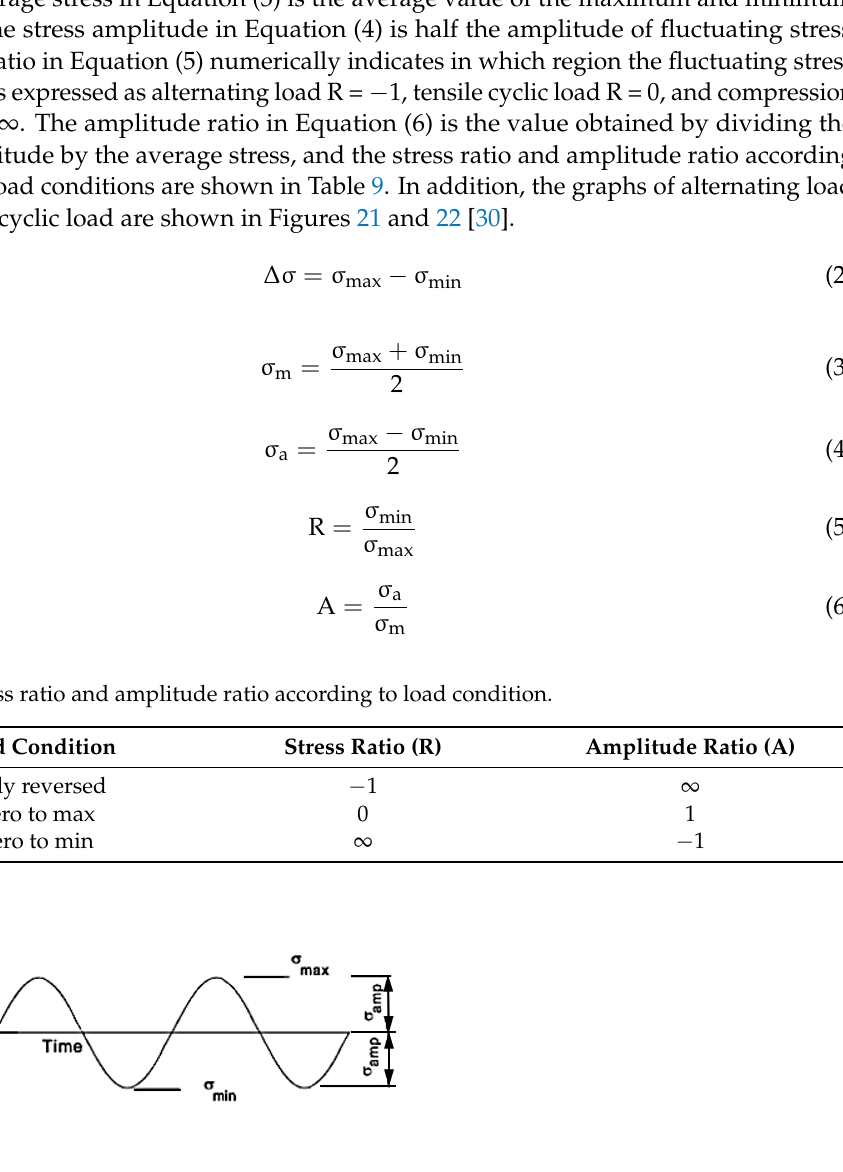
Figure 21. Fully reversed cyclic loads.